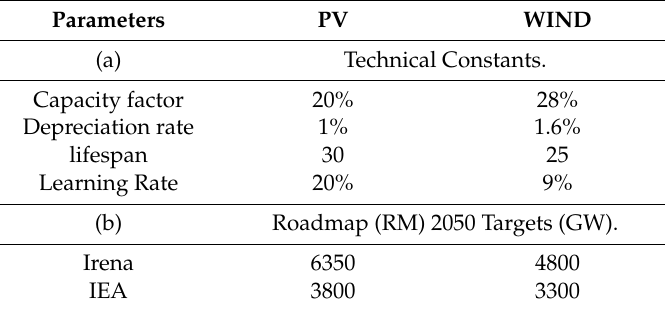
Table A1. Main Roadmap data and technical